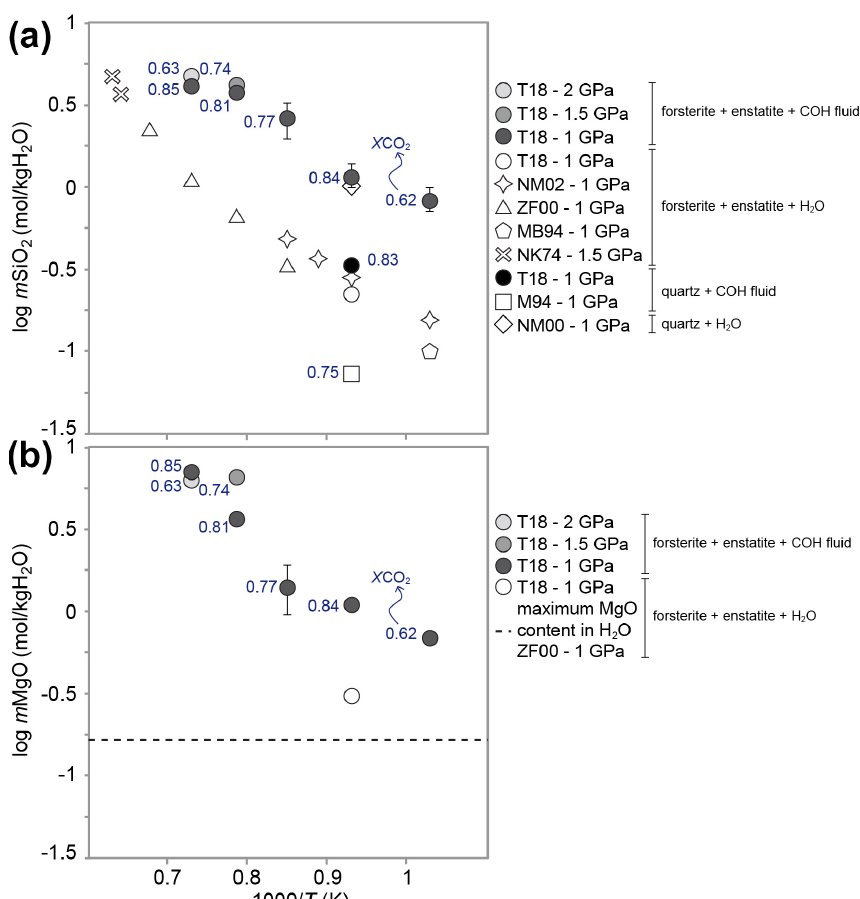
Figure 3. SiO 2 (a) and MgO (b) contents (expressed as mol per kg of water) in GCOH fluids and H 2 O-only fluids as a function of inverse temperature at P = 1–2GPa and T = 700–1100 ◦ C, modified from Tiraboschi et al. (2018). The X CO 2 of the coexisting COH fluid is also reported. T18: Tiraboschi et al. (2018); NM02: Newton and Manning (2002); ZF00: Zhang and Frantz (2000); MB94: Manning and Boettcher (1994); NK74: Nakamura and Kushiro (1974); M94: Manning (1994); NM00: Newton and Manning